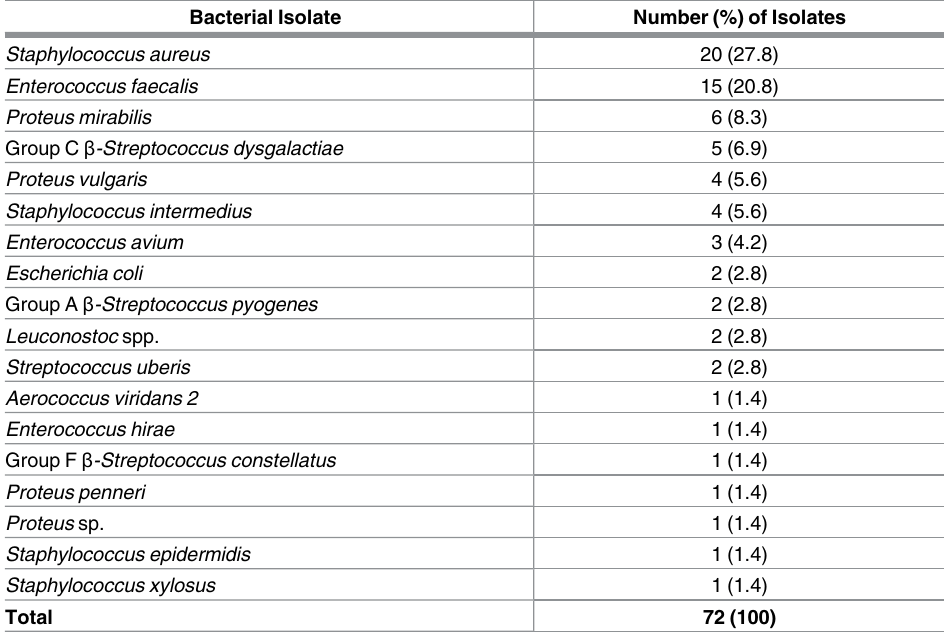
Table 3. Aerobic Bacterial Culture Results from 45 Chambers 1 of ResearchMacaques (n =